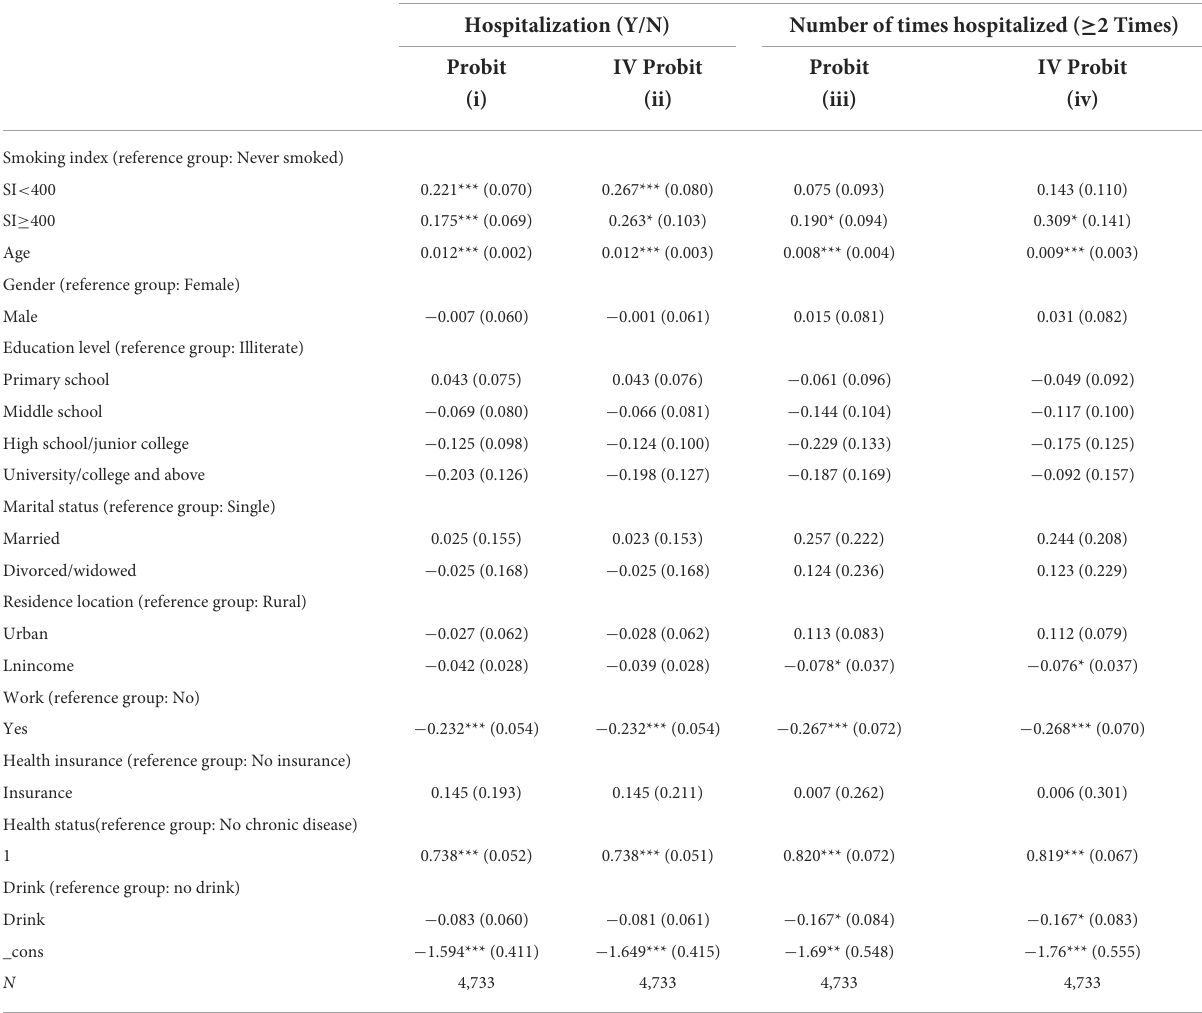
TABLE 4 Probit regression analysis and IV probit regression analysis of inpatient service